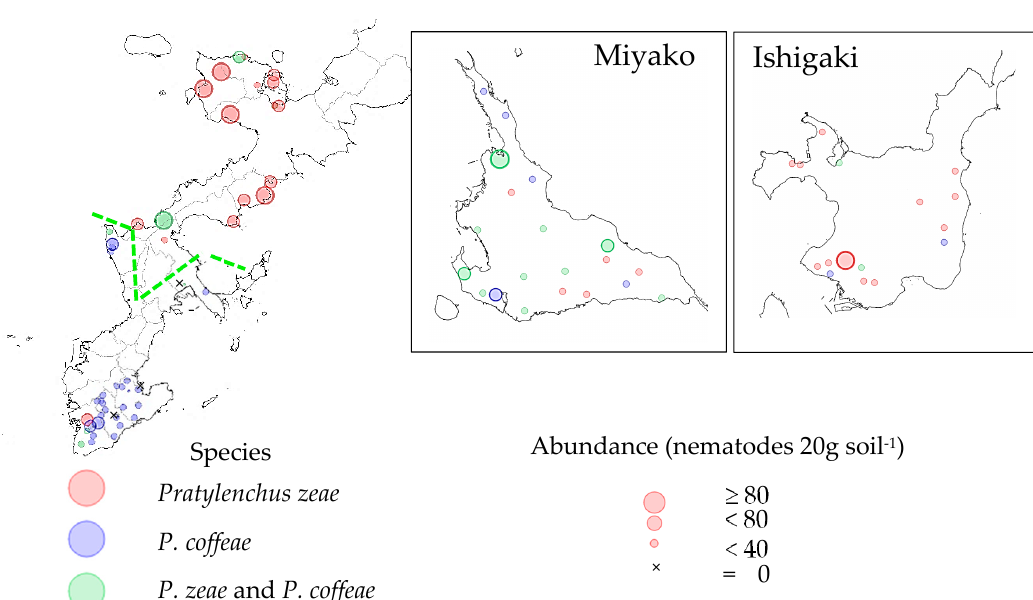
Figure 2. Distribution and abundance of Pratylenchus spp. in Okinawa, Miyako, and Ishigaki. The green dotted line in Okinawa map is to separate North and South. The maps are based on the blank map [21] published by Geospatial Information Authority of Japan [22].